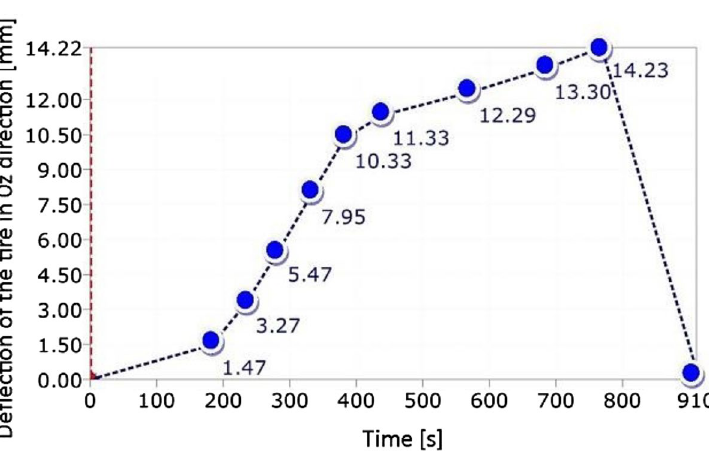
Figure 12. Resultant vector of deflection for the SUV tire under static loading of up to 11 kN.